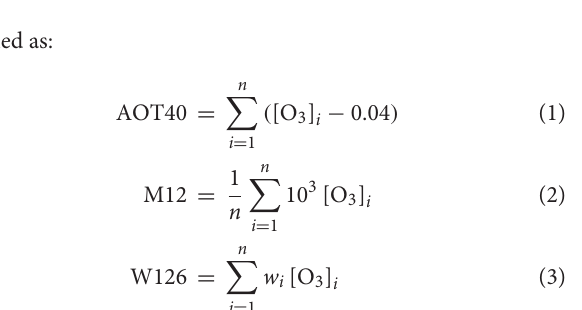
Ozone and Meteorological